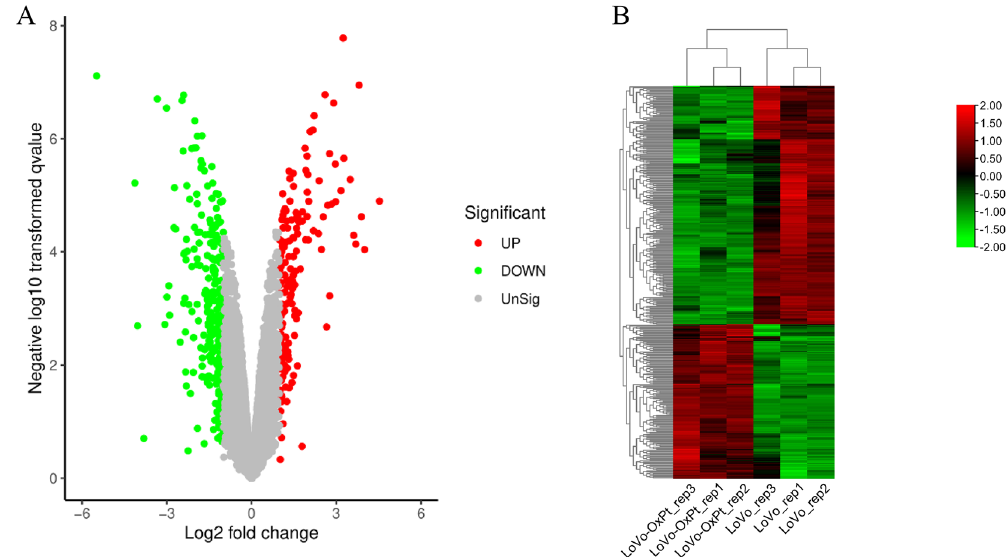
Figure 2. Identification of differentially expressed genes (DEGs). ( A ) Volcano plot of DEGs between parental LoVo and OXA resistant LoVo. ( B ) Heat map showing up-regulated and down-regulated differentially expressed genes (DEGs) in oxaliplatin-resistant LoVo cell